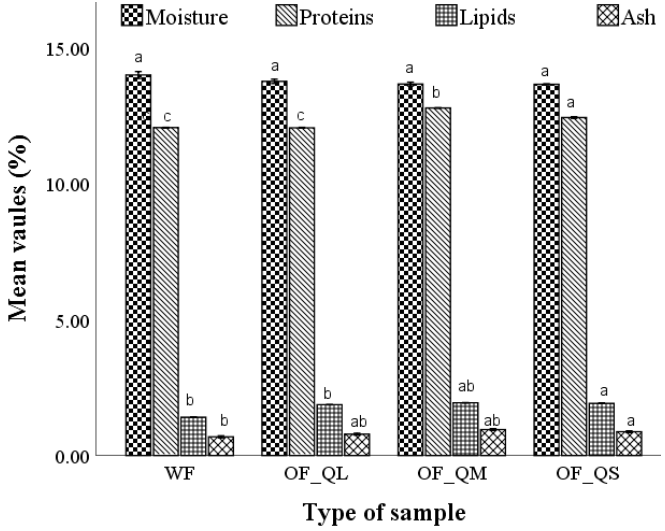
Figure 1. Chemical composition of wheat flour (WF) and optimal wheat–quinoa composite flour with large (OF_QL), medium (OF_QM) and small (OF_QS) particle size. Mean values followed by different letters (a–c) are significantly different ( p < 0.05).